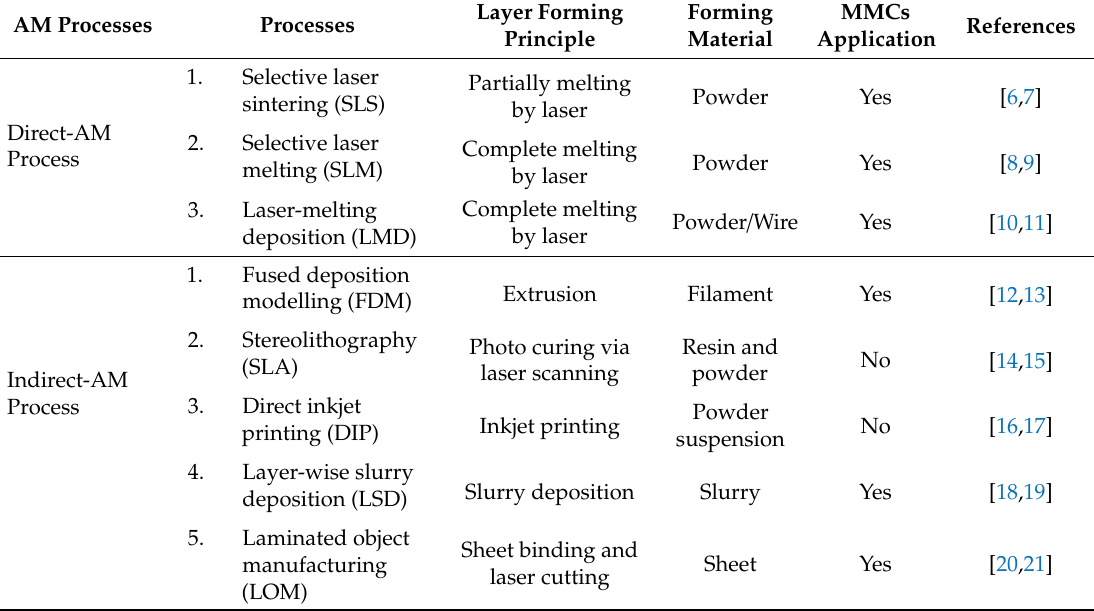
Table 1. Classification of AM